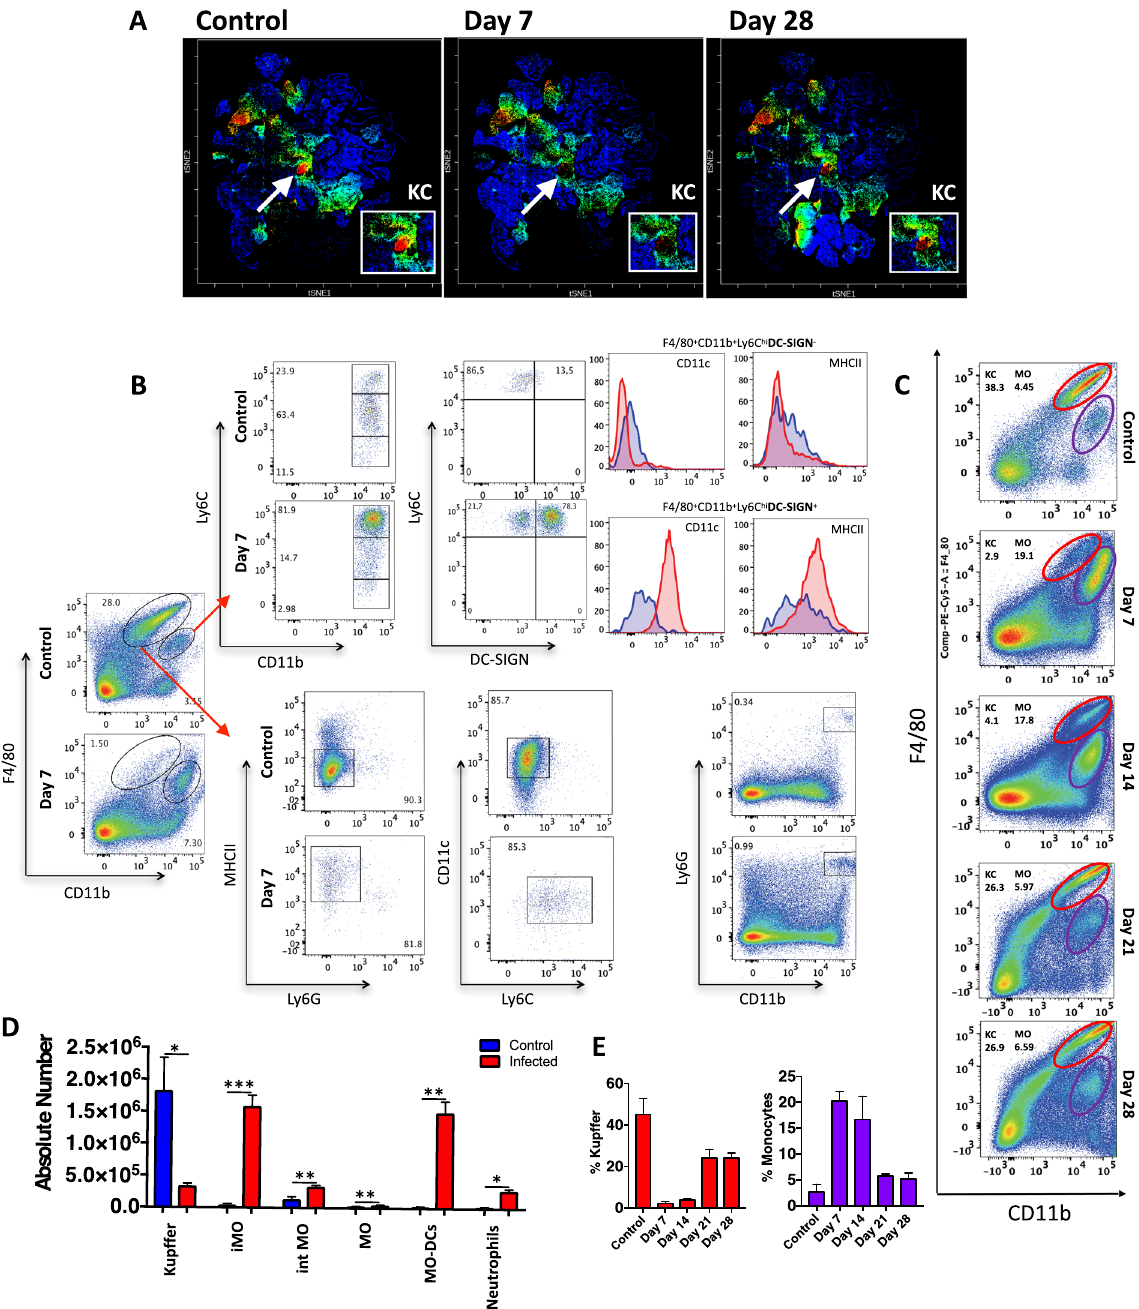
Figure 3. Number of Kupffer cells in the liver during acute phase of P. chabaudi . ( A ) Density dot plot CyTOF showing clustered population based on F4/80 expression. ( B ) Flow cytometry gating strategy to immunophenotyped liver non-parenchymal cells. ( C ) Flow cytometry kinetic of Kupffer cells F4/80 high CD11b + and ( D ) Number of different leukocytes per liver following P. chabaudi infection on day 7 post-infection (n = 5). ( E ) Bar graphs represent the percentage of Kupffer cells and monocytes following P. chabaudi infection. The data shown are representative of 4 independent experiments. Statistical significance comparing infected and non- infected mice (Student’s t test, * p < 0.05, ** p < 0.01, ***p <